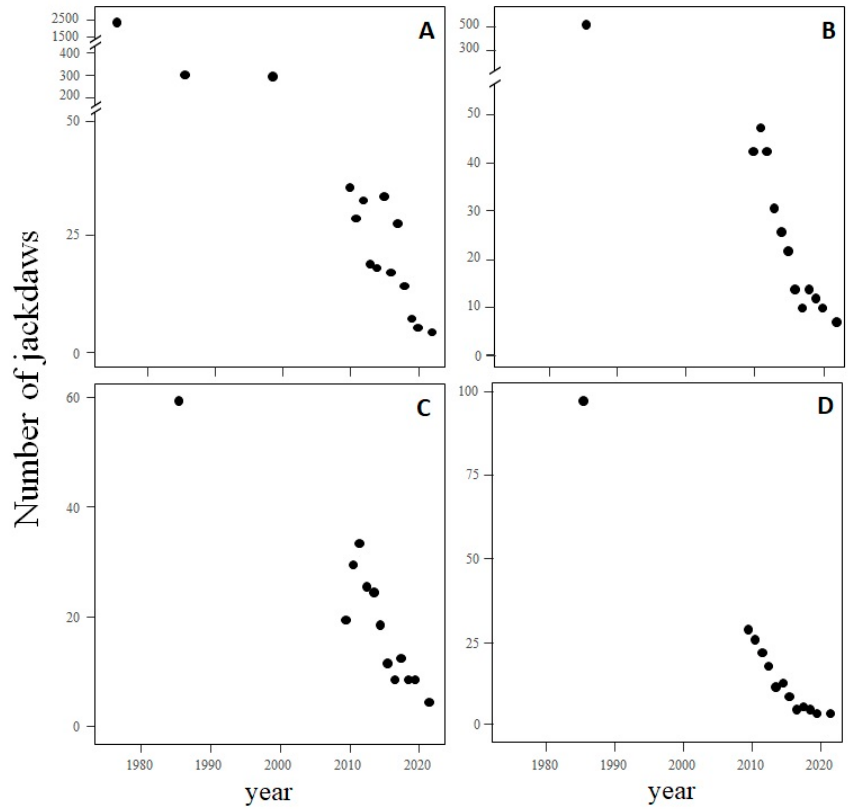
Figure 3. Trends in the number of breeding pairs of jackdaws nesting in each cliff sector ( A – D ) in Madrid province, Central Spain (see Figure 1 for location of the Table 2. Trends in the number of colonies and breeding pairs of jackdaws in Madrid, central Spain. Data refers to changes considering the same sample of colonies censused in 1984–85 [61] and re-sampled in 2009–11 (this study). Zone refers to the geographical areas specified in Figure 1.